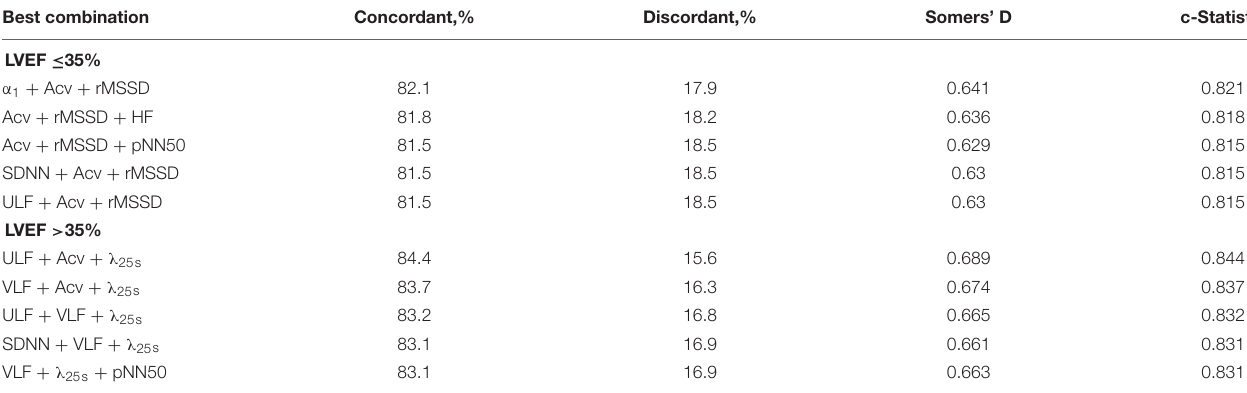
TABLE 5 | Combinations of three predictors with the top five predictive performance. Best combination Concordant,% Discordant,% Somers’ D